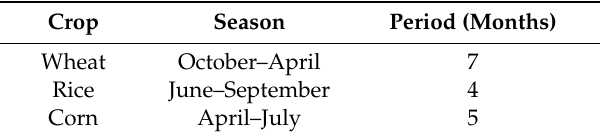
Table 1. The time spans used for standardized precipitation evapotranspiration index (SPEI) calculation for droughts estimation during di ff erent cropping